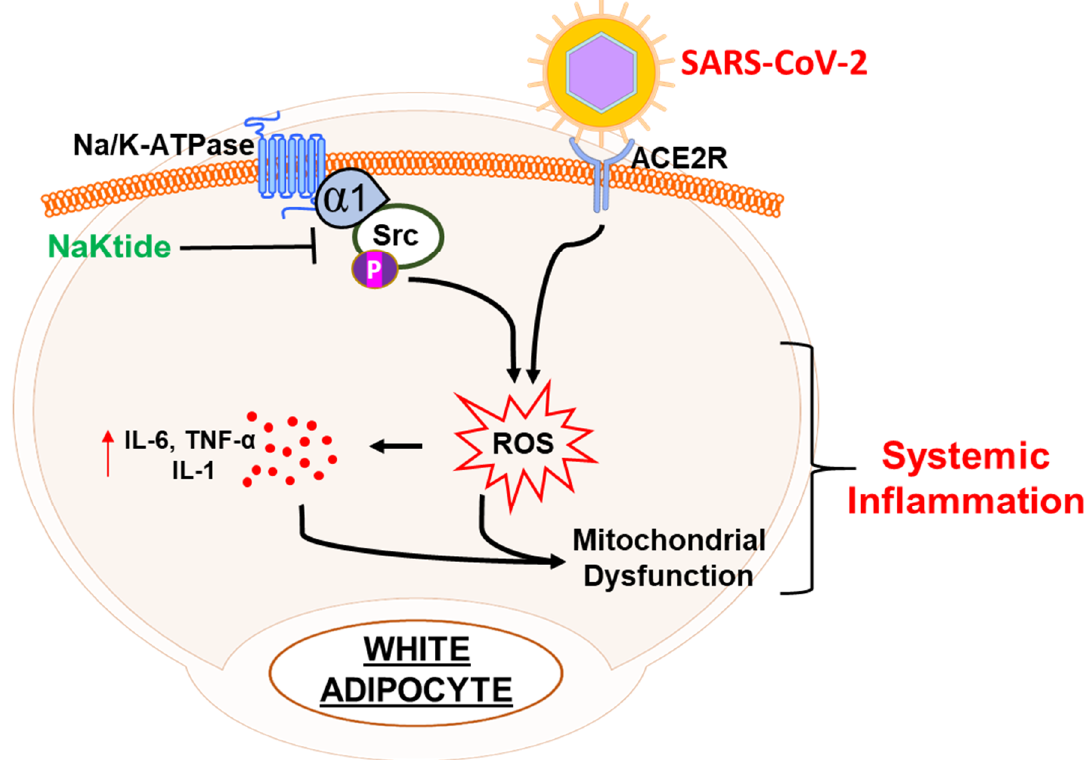
Figure 1. Adipocytes, NaKtide, and COVID-19 inflammation.